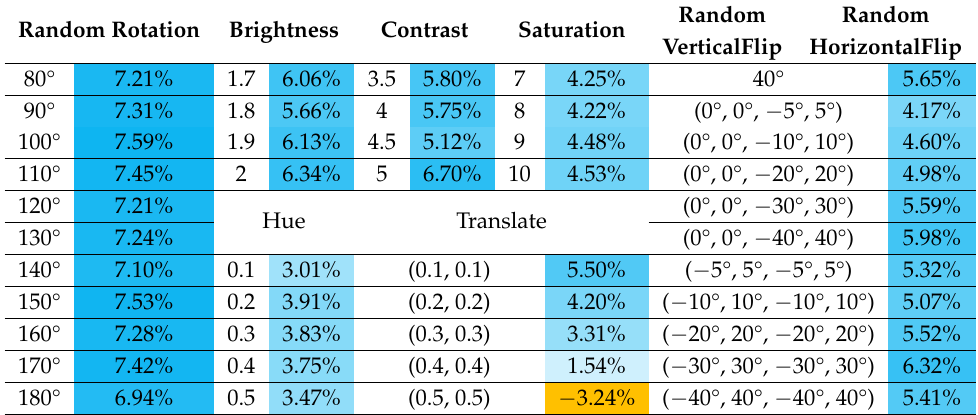
Table A3. Cont. Random Rotation Brightness Contrast